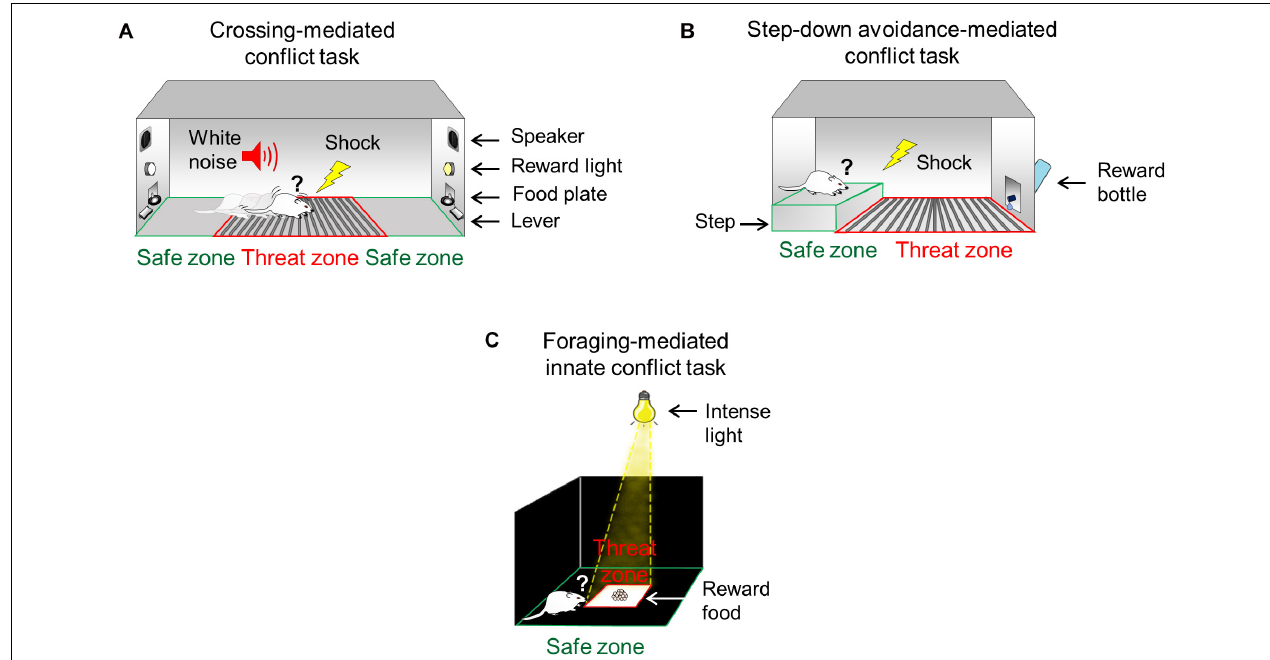
FIGURE 1 | Conflict test battery to study the ability to confront threats in pursuit of rewards. (A) During the crossing-mediated conflict task, hungry rats are trained to repeatedly choose to cross a grid (threat zone, red) to press a lever to obtain food (pellets, reward) in the opposite side of the straight alley (safe zone, green), guided by conditioned cues (white noise and light). (B) During the step-down avoidance-mediated conflict task, thirsty rats are trained to choose to step down from an elevated platform (safe zone, green) onto a conditioned grid (threat zone, red) to approach a bottle containing sweetened water (saccharin, reward). (C) During the foraging-mediated innate conflict task, hungry rats must choose to move from the periphery of the arena (safe zone, green) to enter the intensely illuminated center of the arena (threat zone, red) to obtain food (pellets, reward).